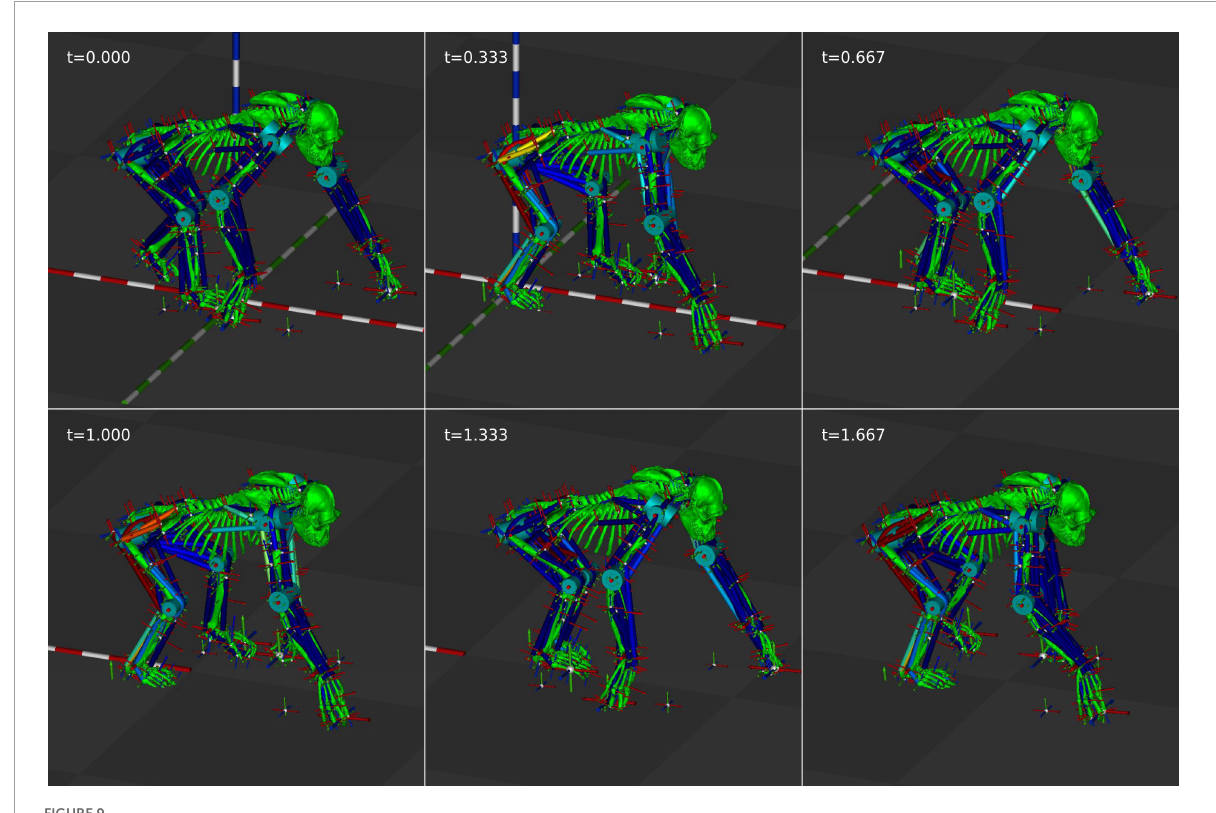
FIGURE9 Still frames from the forward velocity optimized animation at 0.333 s